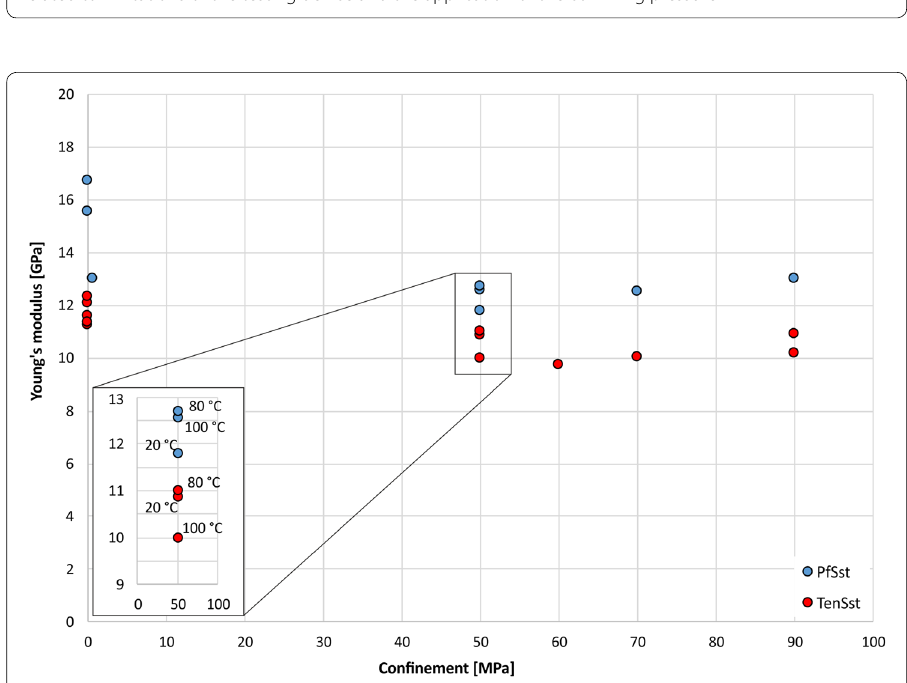
Fig. 5 Young’s moduli related to the confinement of the samples for PfSst and TenSst; the tests were performed at room temperature, except for two samples with higher temperatures (80 °C and 100 °C). Not shown are values above 20 GPa for PfSst (see Table